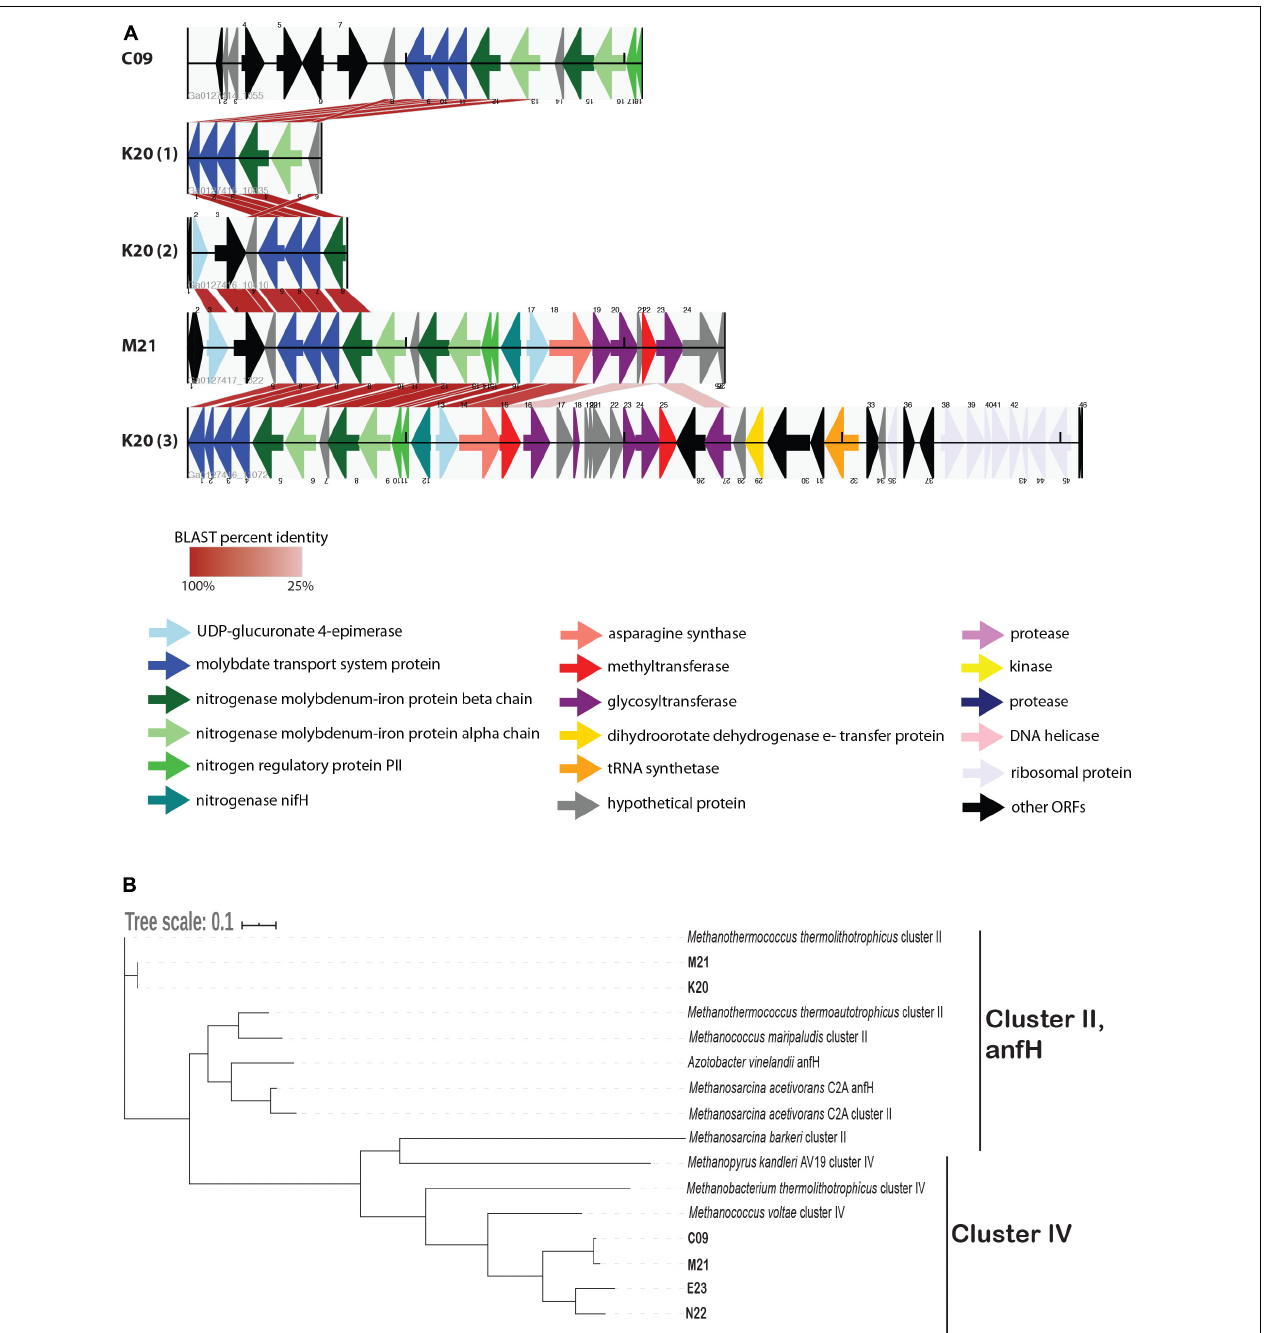
FIGURE 4 | (A) Alignment of open reading frames (ORFs) associated with nitrogenase genes encoded in Methanothermococcus SAGs. The ORFs are represented by arrows indicating the direction of transcription. ORFs are color-coded according to their predicted function as determined by the JGI IMG annotation pipeline. Cross-links indicate the best match to the ORFs on the corresponding contig as determined by BLAST analysis; shading of the cross-link indicates the BLAST percent identity, with darker red colors corresponding to higher percent identity. (B) Maximum likelihood tree depicting phylogenetic relationships among nifH genes identified in Methanothermococcus SAGs. SAG gene numbers are included in the SAG leaf name, and GenBank taxID for reference sequences are included in the Methods. The tree depicts sequences from cluster II and cluster IV nitrogenases. Note that the cluster II nitrogenases included in the tree appear as teal arrows in the ORF diagram. The tree was constructed with RAxML with 100 bootstraps. The scale bar reflects branch lengths in terms of substitutions per site.